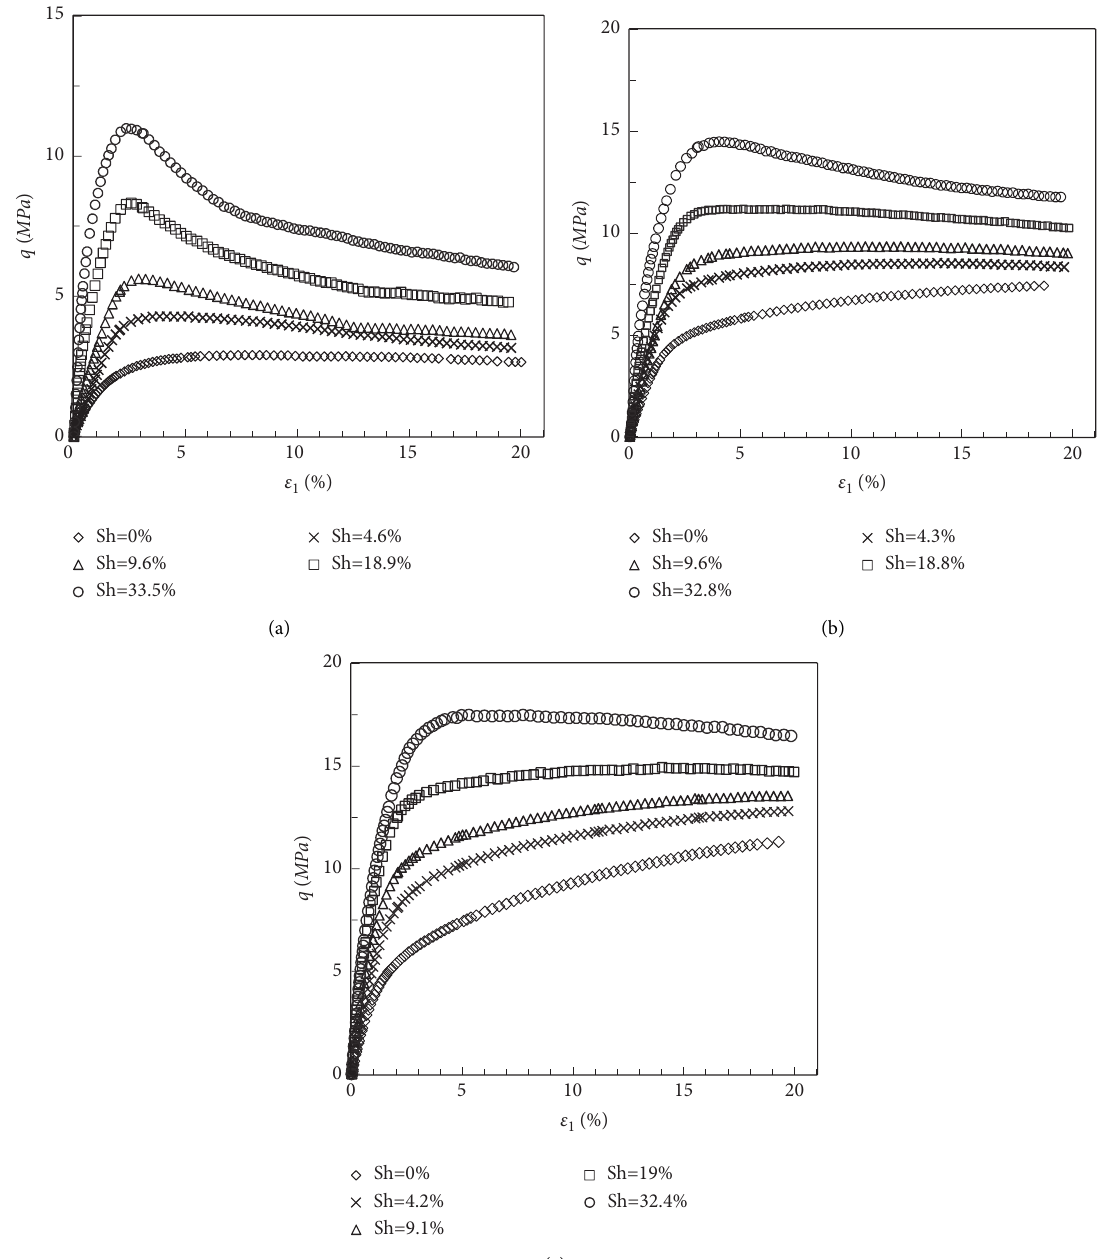
Figure 3: The stress-strain curves of hydrate-bearing sand: (a) σ